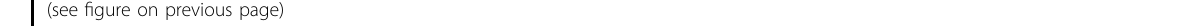
Fig. 1 TINCR is highly expressed in human breast cancer. a Hierarchical-clustering heatmap of differentially expressed lncRNAs in breast-cancer and adjacent normal tissues, generated from RNA-seq data from TCGA. Colors: expression levels indicated by log 2 -transformed scale bar below the matrix; red and blue: max and min expression levels, respectively. b Volcano plot of lncRNAs differentially expressed between breast-cancer tissues normal tissues. P < 0.001, fold change >1.2 or fold change < – 1.2. c – e TINCR expression in cancer and normal tissues from 1104 breast cancer patients in TCGA cohort ( c ), 1,085 breast-cancer patients in GEPIA cohort ( d ), and 125 breast-cancer patients in HMUCC cohort ( e ). f TINCR expression in breast cancers of different TNM stages in TCGA database. ( g , h ) GO and KEGG analyses of TINCR. P < 0.05 indicated statistical signi fi cance. Vertical axis: biological process or pathway category; horizontal axis: − log 10 ( P value) of signi fi cant biological process or pathway. * P < 0.05, ** P < 0.01, *** P < 0.001, **** P <